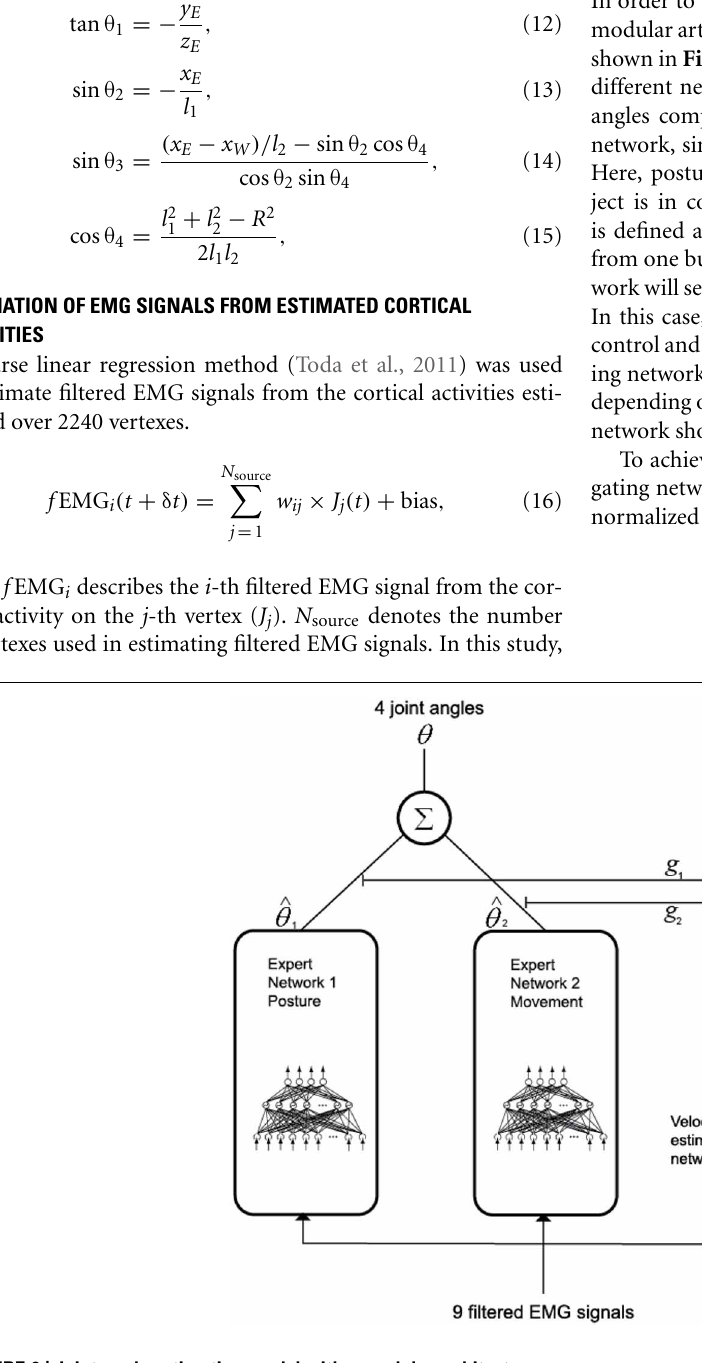
FIGURE 6 | Joint-angle estimation model with a modular